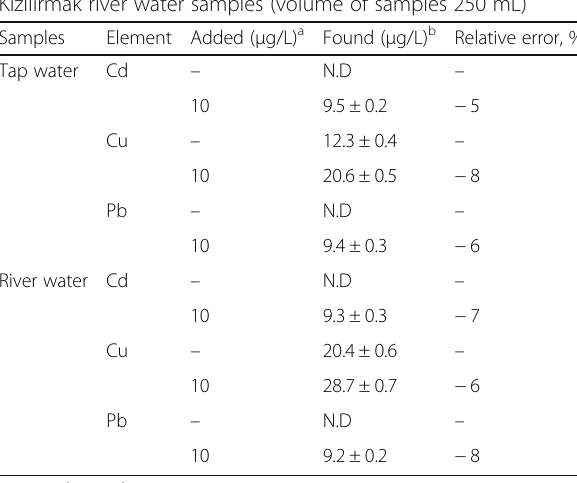
Table 4 Determination of Cd, Cu, and Pb in tap water and